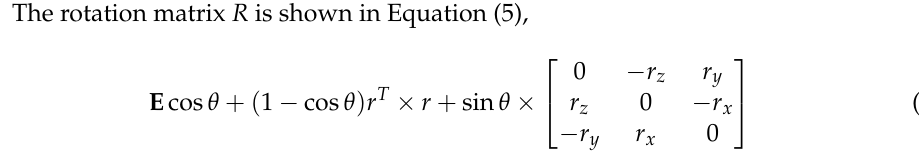
Figure 7. The schematic diagram of Rodrigues’ rotation formula.